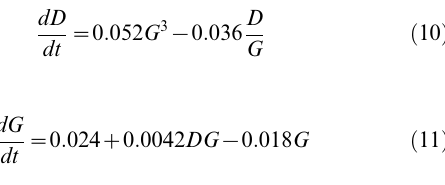
) as a function of D and G . The black line is the solution dD dt